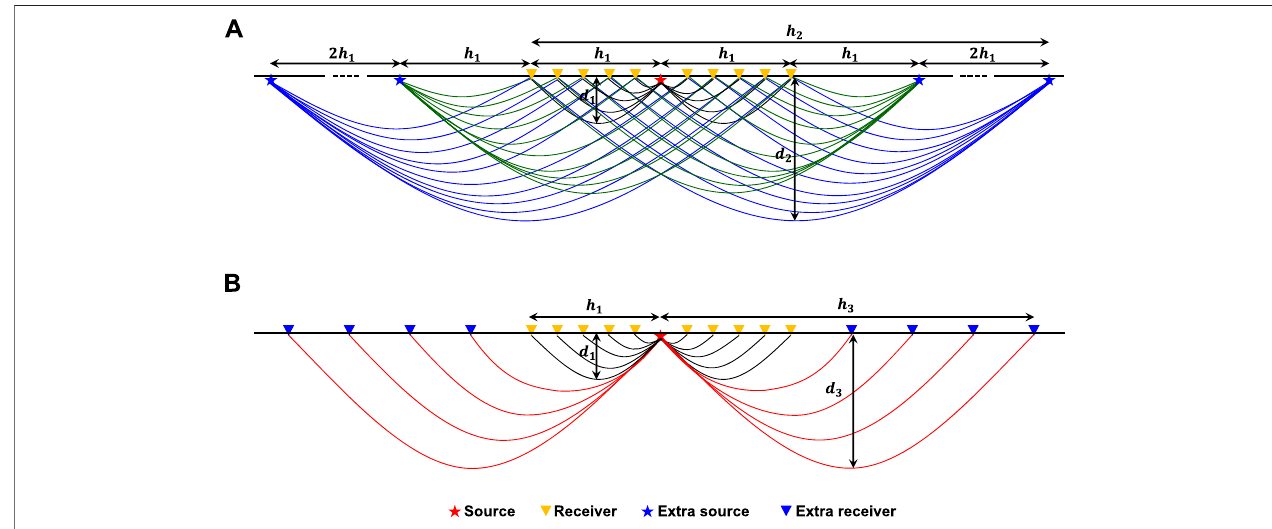
FIGURE 3 | (A) Type-I modi fi ed geometry: extra sources are added into the normal geometry, that is, the red star source and yellow receivers. h 1 represents the maximumoffsetofthereceiverarrayinthenormalgeometrypart.The fi rstextrasourceissetatadistanceof h 1 tothenearestreceiver.Theintervaloftherestoftheextra sourcesis2 h 1 . (B) Type-IImodi fi edgeometry:extrareceiversareaddedintothenormalgeometry.Theintervaloftheextrareceiversismuchsparserthanthereceiversof the normal geometry part. h 2 and h 3 indicate the maximum offset of the modi fi ed geometries for acquiring diving waves. d 1 , d 2 and d 3 represent the maximum penetration depth of the diving waves.